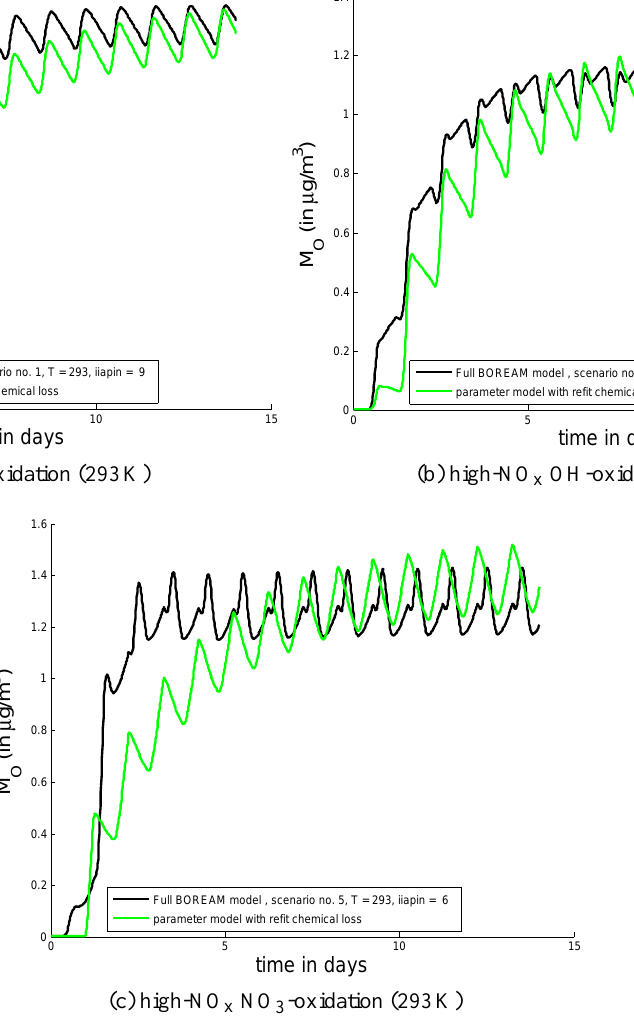
Fig. 4. Time evolution of M O for three examples of the simulations of α -pinene oxidation. The full model results are given in black and the parameter model results in green.